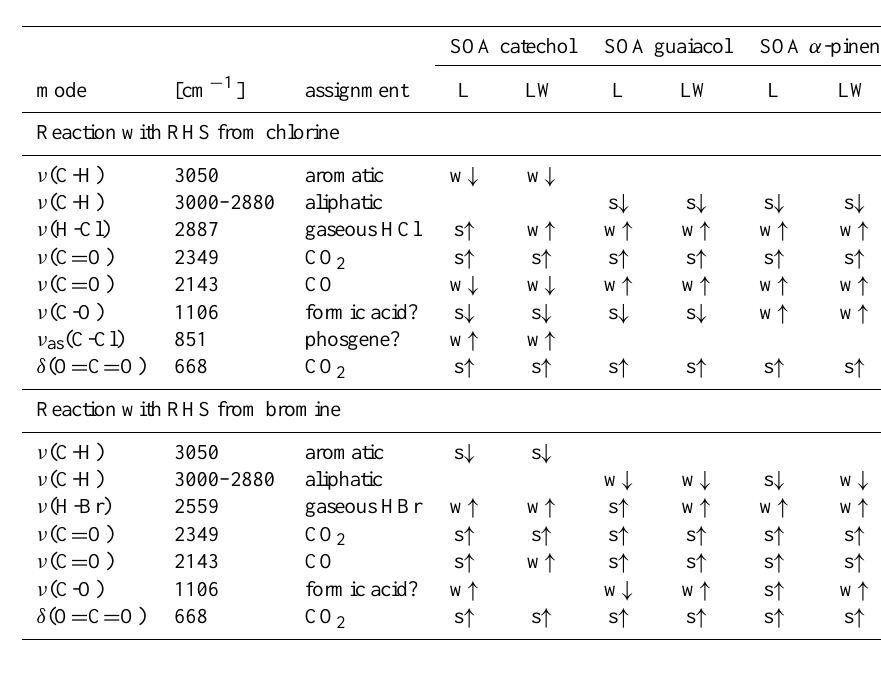
Table 1. Assignment of measured absorptions to functional groups from SOA reacting with RHS using long-path absorption FTIR spec- troscopy (L: simulated sunlight at 0% relative humidity; LW: simulated sunlight at 25% relative humidity; w: weak; s: strong; ↓ : destruction; ↑ : formation).